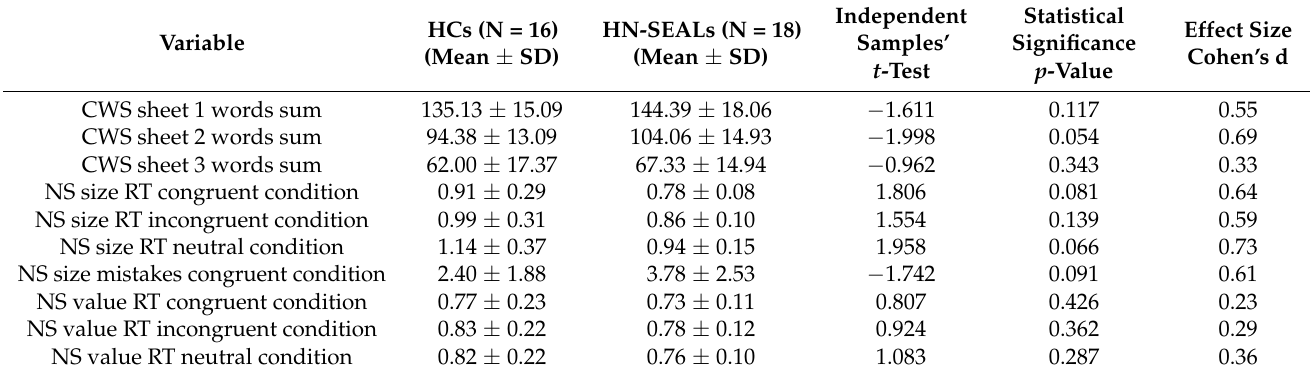
Table 3. Independent sample t -test for equality of Stroop mean values between HN-SEALs and HCs.